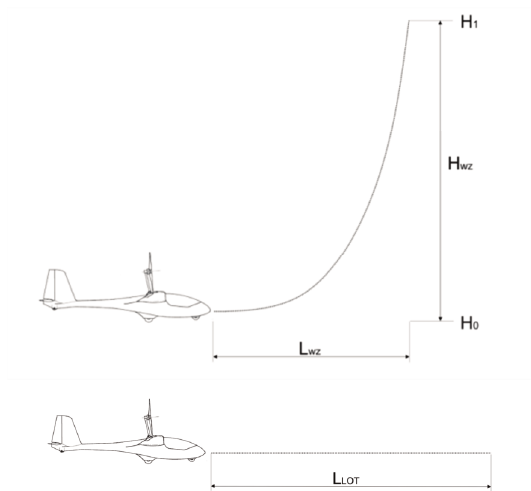
Fig. 12. Flight profile – climb (up) and horizontal flight (down)